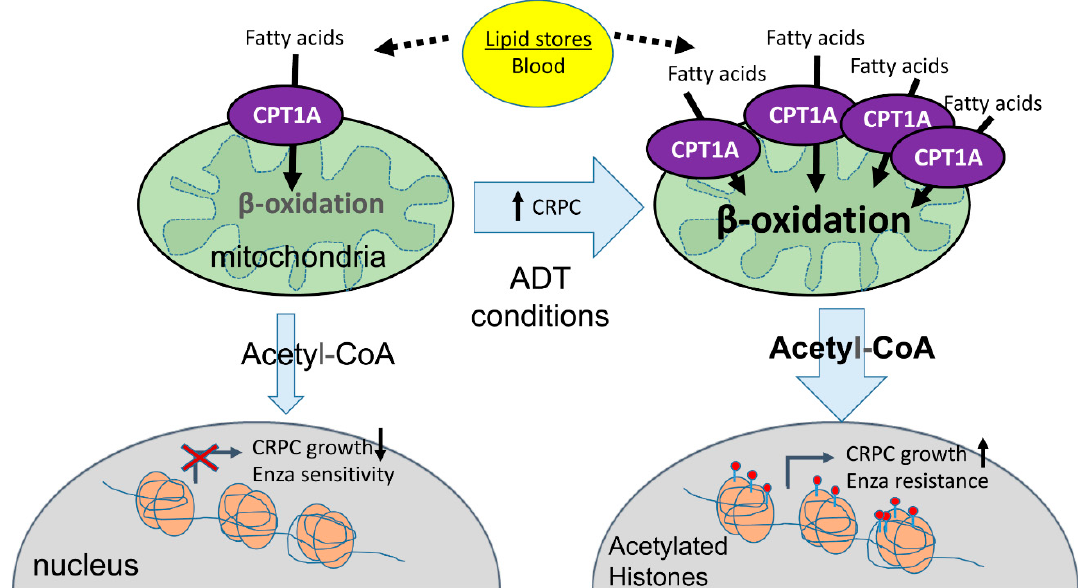
Figure S2: Growth and migration of 22Rv1 cells with CPT1A knockdown and overexpression. Supplementary Figure S3: Seahorse OCR traces and AR isoforms expression in 22Rv1 cells with CPT1A knockdown and overexpression. Supplementary Figure S4: Mitochondrial content of 22Rv1 cells with CPT1A knockdown and overexpression. Supplementary Figure S5: Supplementary data to Figure 6. Table S1: Primer information for RTPCR. Table S2: List of antibodies used in the study. Supplementary methods: Digestion, peptide isolation and MS analysis of histones.